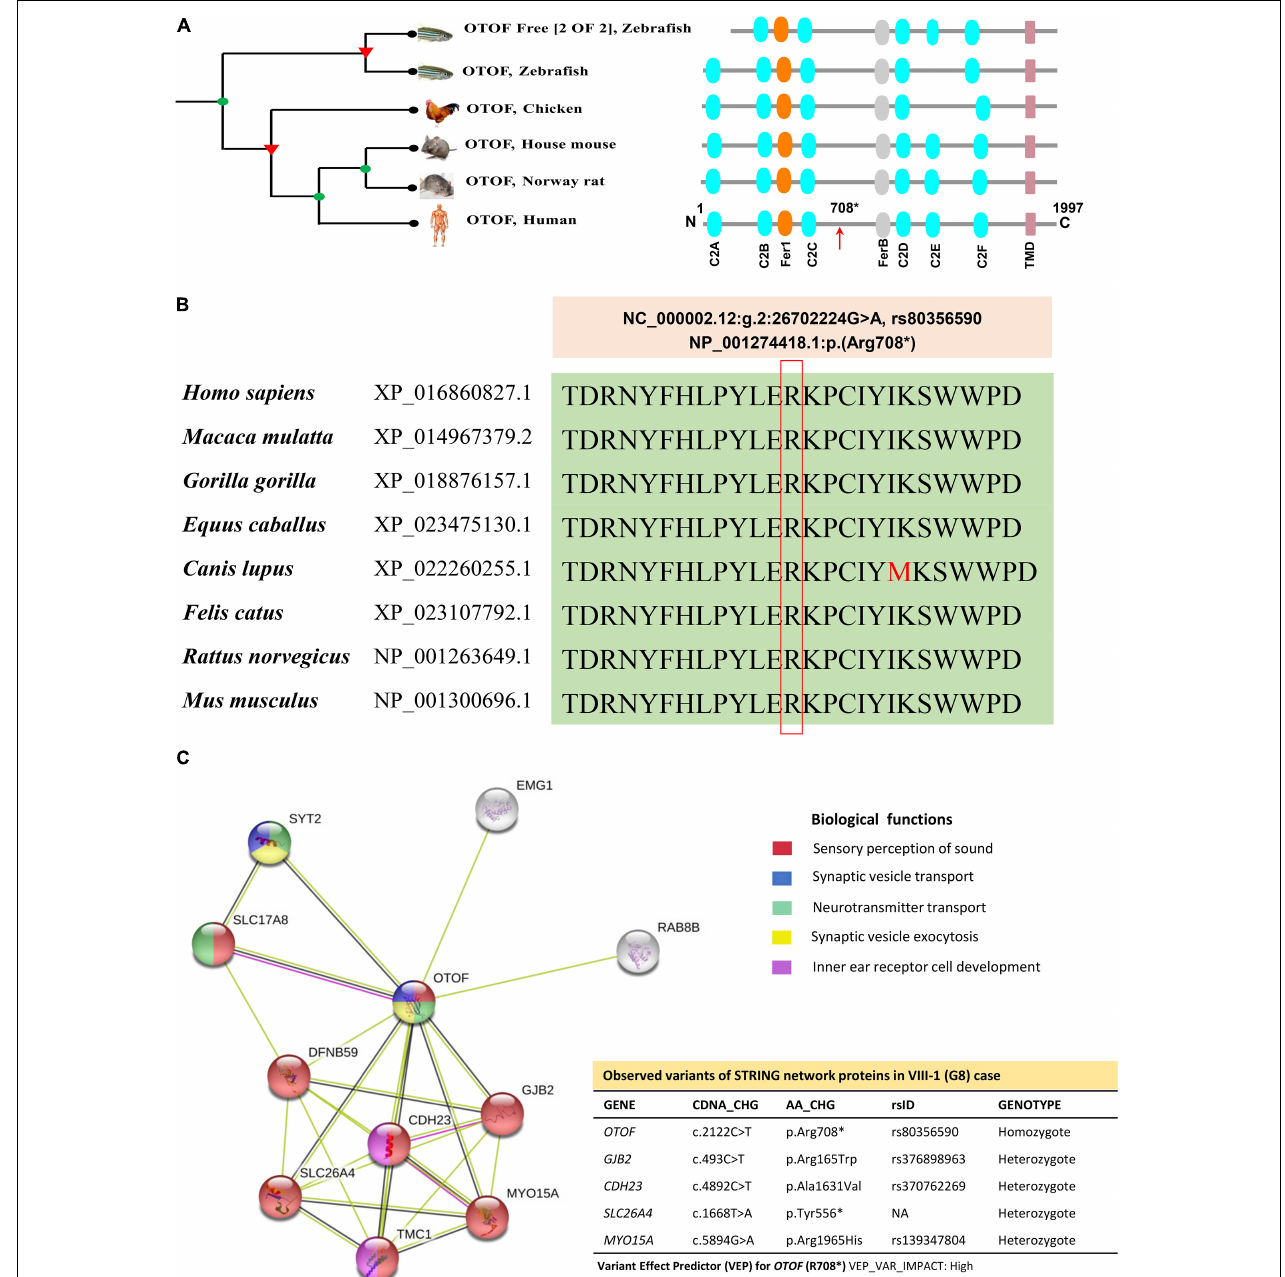
FIGURE 5 | The phylogenetic relationship, conservation and association networks of OTOF protein. (A) The human OTOF protein domains show high resemblance with mouse and rat except for the chicken and zebrafish, which lacks the C2E domain. Ferlin1, FerlinB and Trans-membrane domains are common among all species. (B) The comparison of OTOF for 8 vertebrates shows a highly conserved region (at Arg708 residue) spanning between C2C and FerB domains across different vertebrates. (C) Network showing the functional association of OTOF using STRING v11.0 (https://stringdb.org/). The proximity of the proteins via threads predicts the association and their role in sensorineural activities. In the present study, exome-data have also identified the additional genomic variants in CDH23, GJB2, MYO15A, OTOG, and SLC26A4 for the current STRING